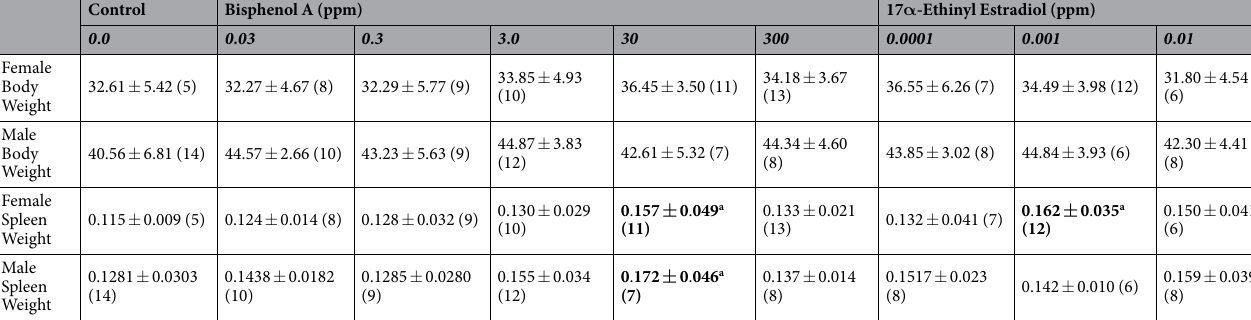
Table 1. Body and Spleen Weights at Necropsy (g). Values represent group means ± SD ( n ) ; a Significantly different from control by Dunnett’s multiple comparison test ( p <